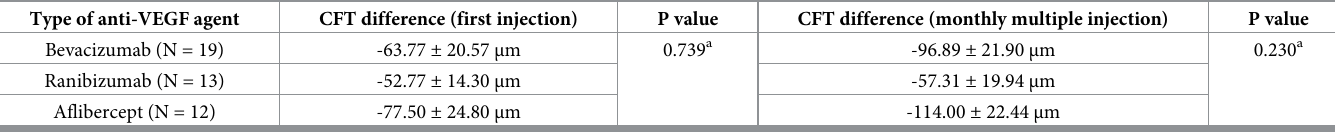
Table 4. Central foveal thickness (CFT) difference by anti-vascular endothelial growth factor (VEGF) agent type.